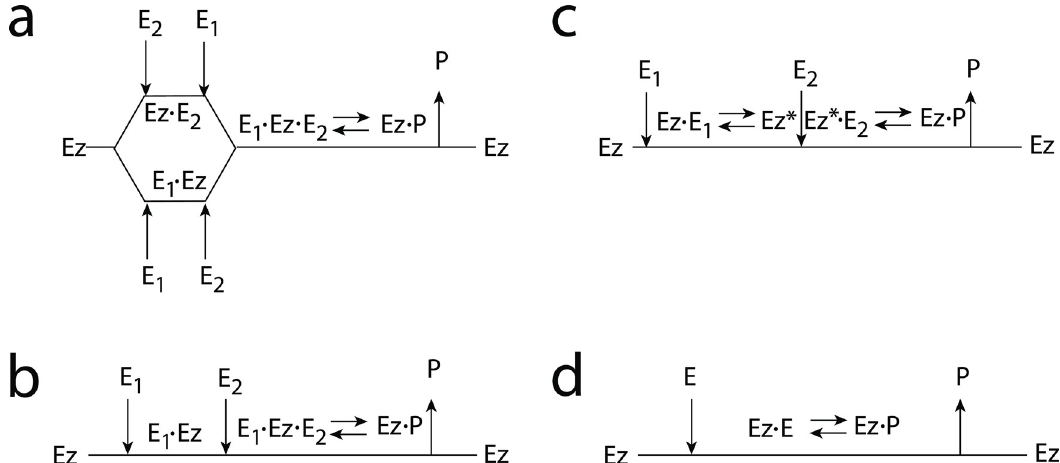
Fig 4. Overview (Cleland notation [19]) of the enzymatic mechanisms removing E 1 and E 2 (Eq 4). (a) Ternary complex mechanism with random binding of E 1 and E 2 to the enzyme. (b) Ternary complex mechanism with compulsory binding order. Here E 1 binds first to free enzyme Ez then E 2 binds to the E 1 � Ez complex. Alternatively, E 2 can bind first to Ez and then E 1 to form the ternary complex. (c) Ping-pong mechanism. E 1 (or E 2 ) bind first to Ez leading to the alternate enzyme form Ez � , which then can bind E 2 (or E 1 ). (d) Single-substrate Michaelis-Menten mechanism used in single-E